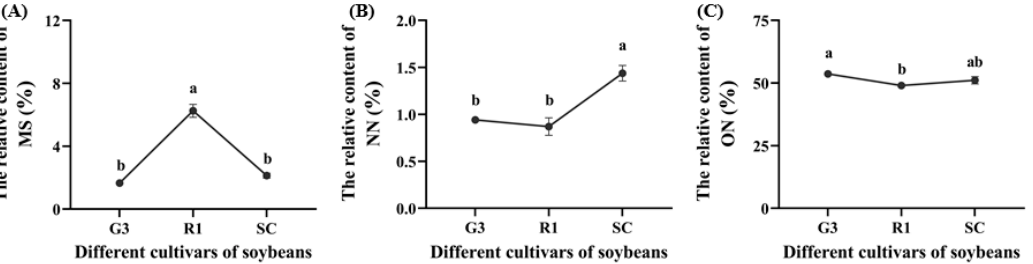
Figure 6. The relative content of methyl salicylate (MS) ( A ), nonanal (NN) ( B ) and 3-octenol (ON) ( C ) in different soybean cultivars. Data are means ± SEM. The lowercase letters in the figure indicate significant differences among different cultivars ( p < 0.05, Tukey test).